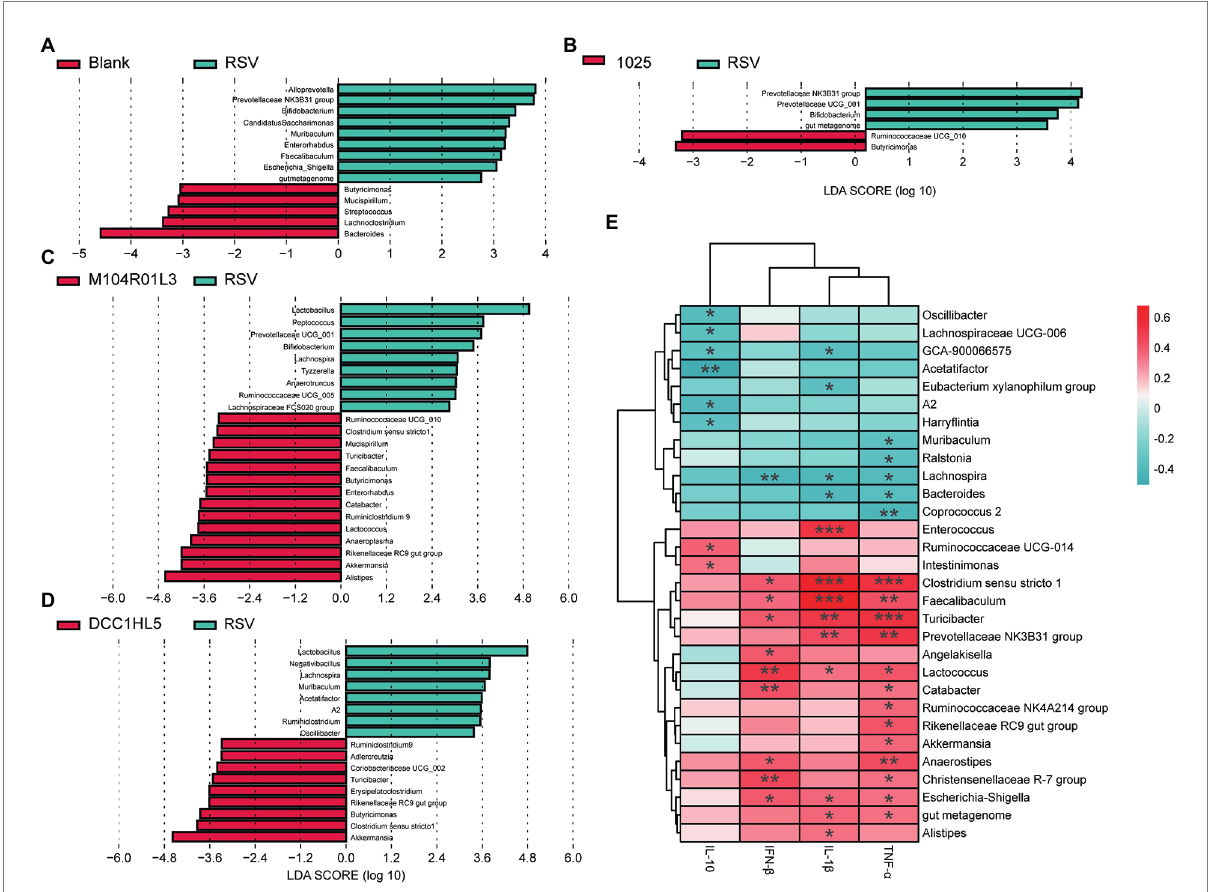
FIGURE 5 Impact of three Lactobacillus mucosae strains on the relative abundance of bacterial genera and correlation analysis. Linear discriminant analysis effect size (LEfSe) comparison of gut microbes at the genus level between (A) blank and RSV groups, (B) 1,025 and RSV groups, (C) M104R01L3 and RSV groups, and (D) DCC1HL5 and RSV groups. (E) Correlations between cytokines and gut microbiota. ( n = 8; * p < 0.05, ** p < 0.01, *** p < 0.001). Blank, not infected RSV. RSV, infected with respiratory syncytial virus and